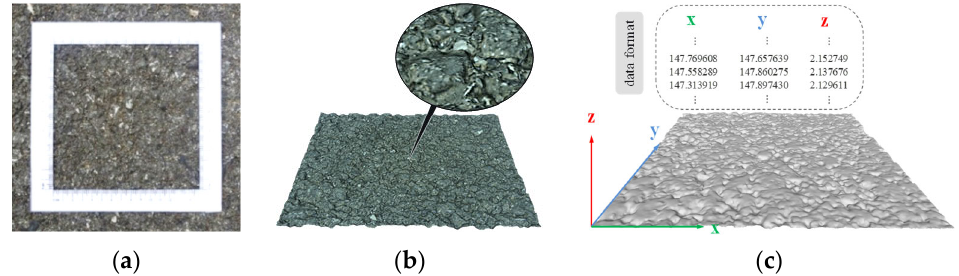
Figure 2. Acquisition of road surface texture information: ( a ) testing range of the pavement texture; ( b ) reconstructed digital pavement model; ( c ) 3D coordinate values.